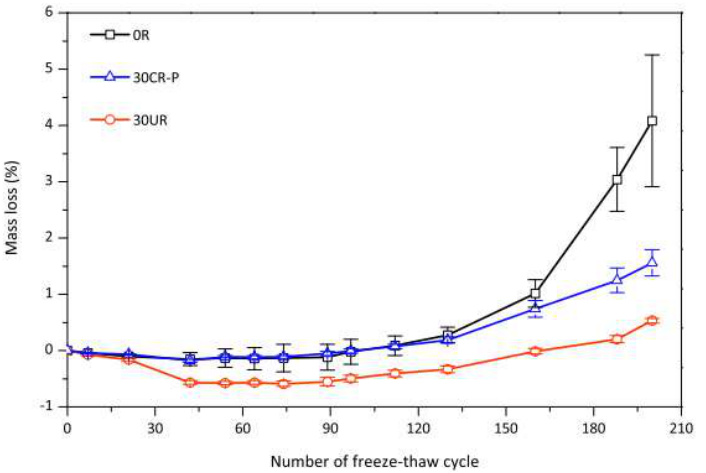
Figure 13. Comparison of mass loss of common mortar and rubber mortar after freeze−thaw cycle [10].